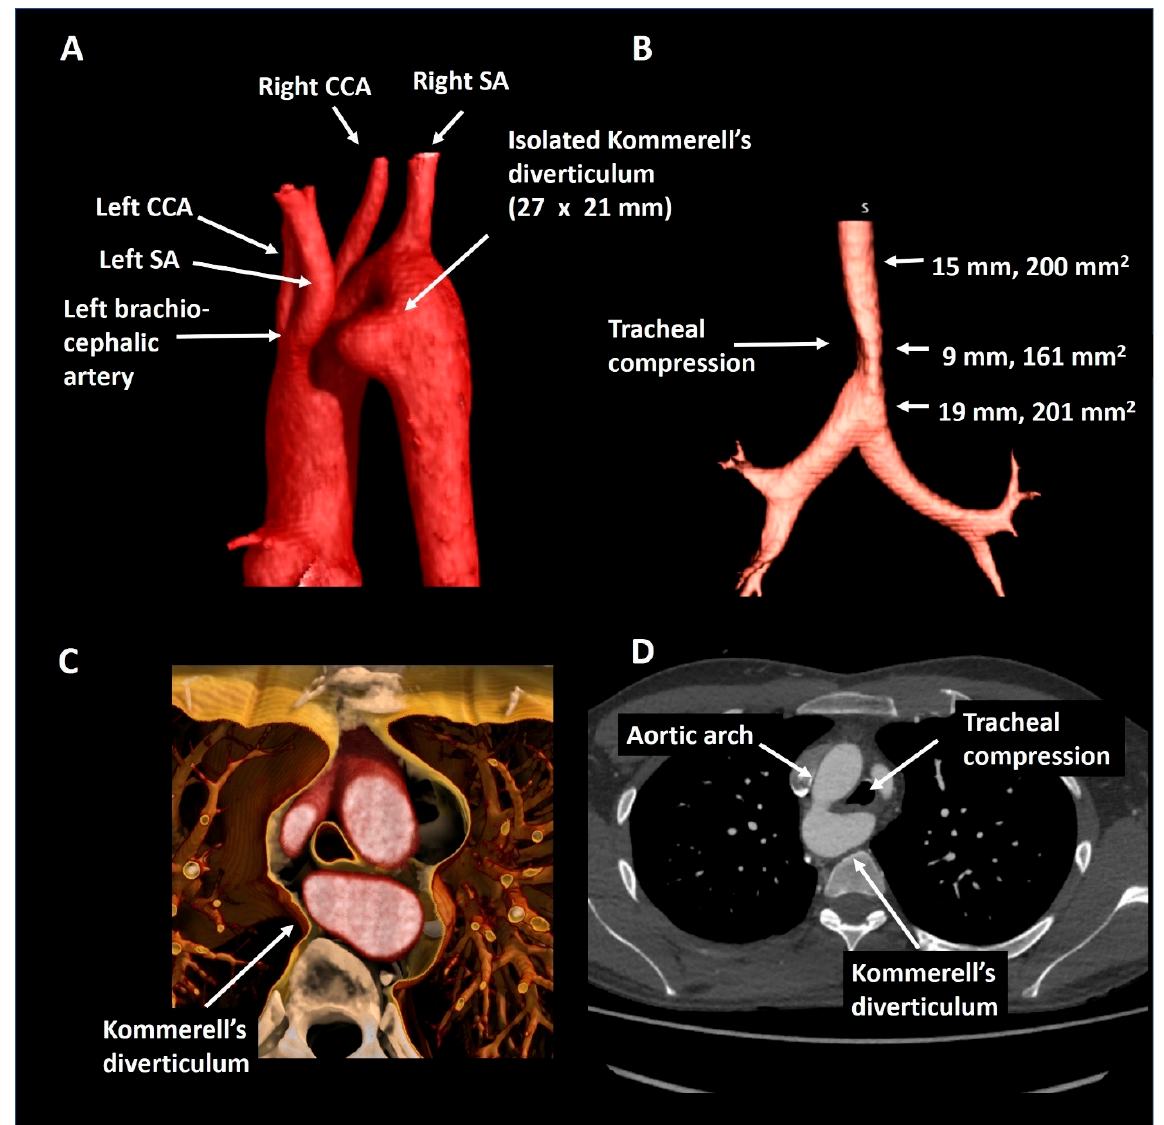
Figure 8. Patient 6. Panel ( A ) shows a posterolateral view of a right-sided aortic arch with mirror imaging branching and an isolated Kommerell’s diverticulum compressing the trachea (panel ( B )) by the formation of a vascular ring (panel ( C )). Panel ( D ) shows the axial reconstruction. CCA, common carotid artery; SA, subclavian